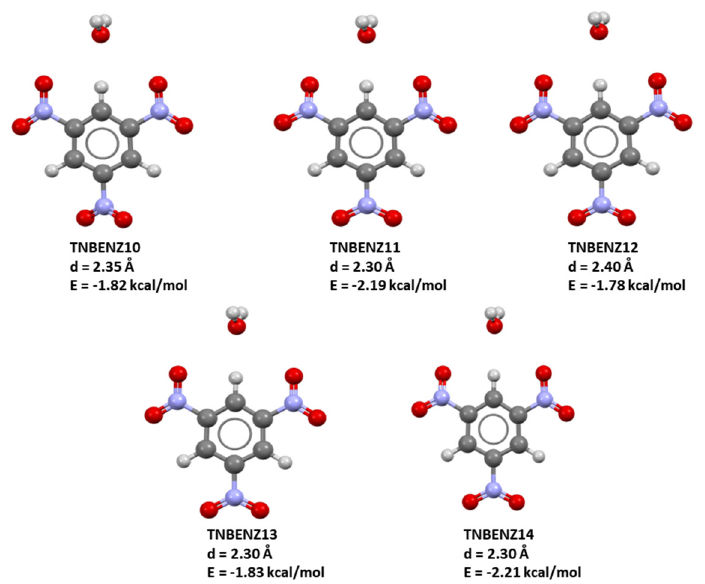
Figure 7. TNB/H 2 O model systems containing TNB geometries extracted from crystal structures and artificially added water molecules. Calculated energies of the strongest interactions with cor- responding O … H distances were given below every model